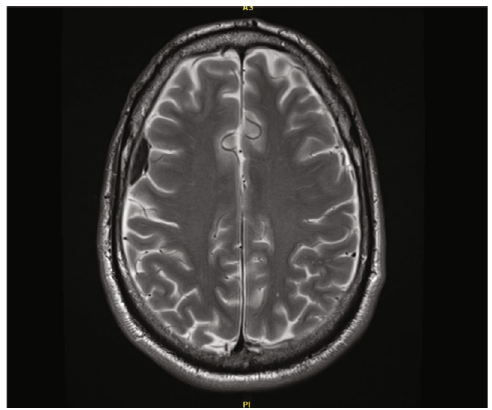
Figure 8: MRI showing left SDH taken at time of presentation in the emergency department.